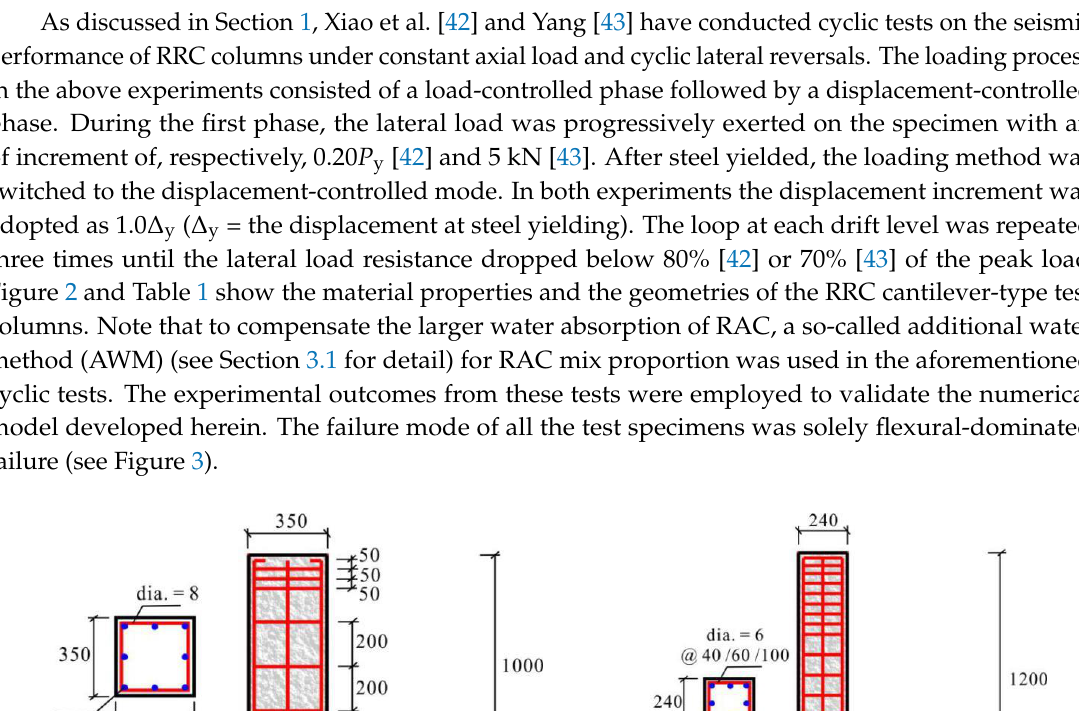
( k ) Figure 3. Flexural failure modes of test specimens. ( a ) NCCC-1 [42]; ( b ) NAC-0.30-40 [43]; ( c ) NAC-0.30-60 [43]; ( d ) NAC-0.30-100 [43]; ( e ) RAC50-0.30-40 [43]; ( f ) RAC50-0.30-60 [43]; ( g ) RAC50-0.30-100 [43]; ( h ) RAC100-0.30-60 [43]; ( i ) RCCC-2 [42]; ( j ) RAC50-0.15-60 [43]; and ( k ) RAC50-0.45-60 [43].